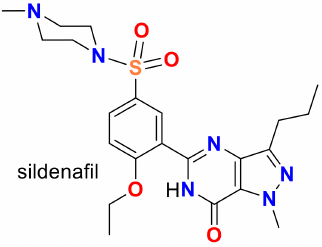
Figure 1. Structure of